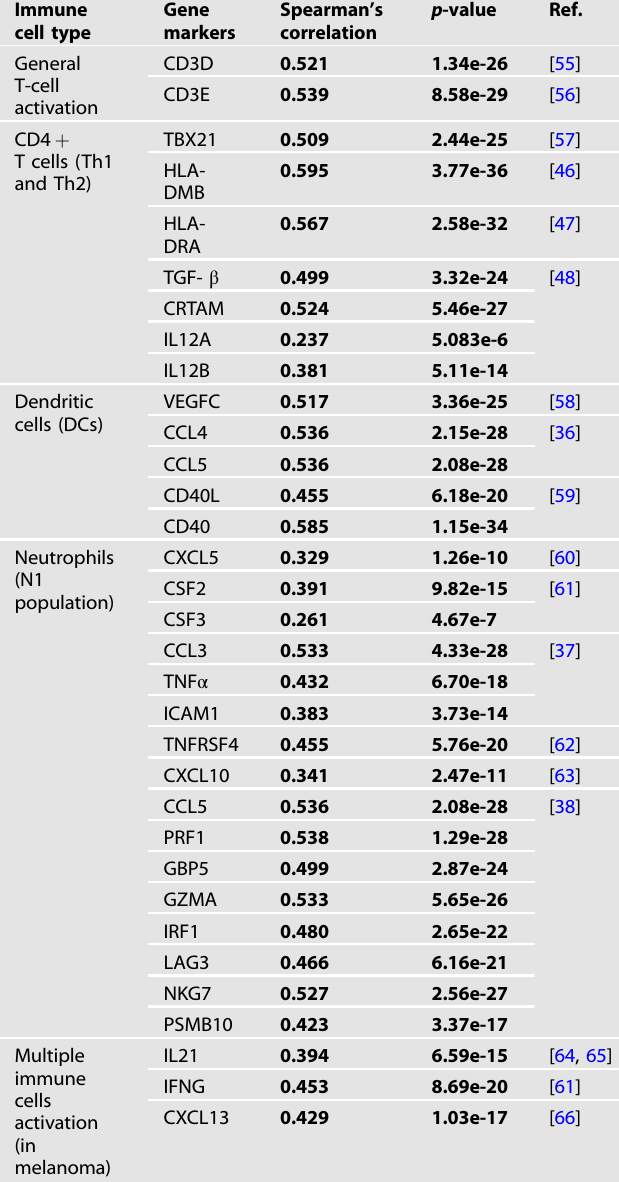
Table 1. TGM2 expression and tumor immune microenvironment activation in